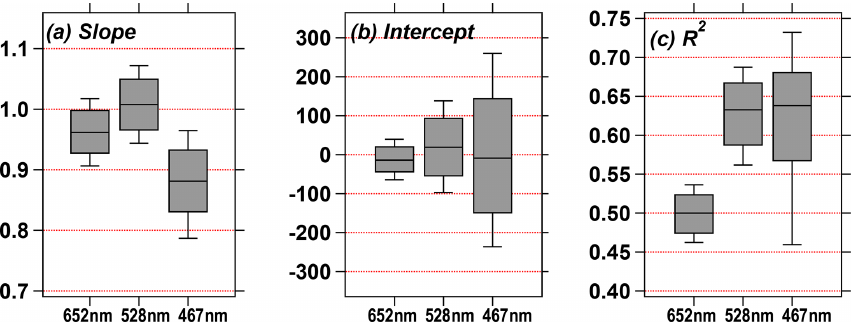
Figure 13. The box-and-whisker plots (slope, intercept, and R 2 ) for the Monte Carlo simulation of the relationship between the CLAP- derived B abs (corrected by Algorithm B in the present work) and “true” B abs for all three